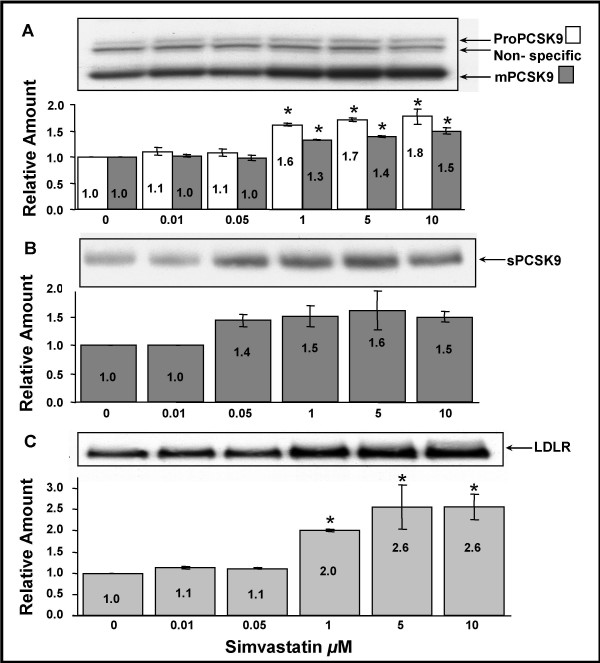
Effect of increasing concentrations of simvastatin on PCSK9 and LDLR expression in HepG2 cells. HepG2 cells were grown in DMEM + 10% FBS and supplemented with increasing concentrations of simvastatin for 24 hours at 37°C. 50 μg of total cell lysates (A and C) and 100 μl cell media (B) were analyzed by immunoblotting (IB), or immunoprecipitation (IP) followed by IB, respectively, as described in Methods. A and B were IB with anti-hPCSK9 Ab and C with anti-hLDLR Ab. The protein signals were quantified by densitometry using Syngene Chemigenius 2XE imager and Gene Tools software. All values were made relative to values from untreated cells set as 1 and presented as mean ± SEM (n = 3). * Indicates significant differences from untreated control (p < 0.05) using student's T-test.